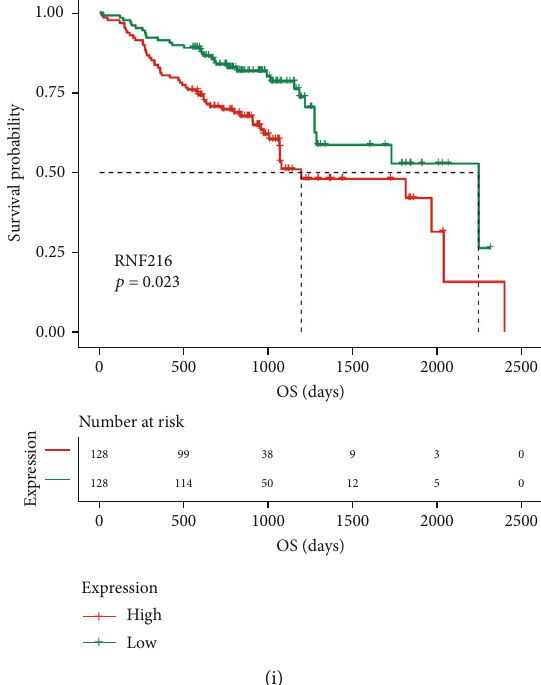
Figure 5: The prognostic value of the nine key IRDEGs ((a) IGSF5 , (b) NKX2-3 , (c) HLF , (d) ALDH2 , (e) IFIT2 , (f) FXYD5 , (g) CTSL1 , (h) IFNAR1 , and (i) RNF216 ) in HNSCC patients in the overall survival